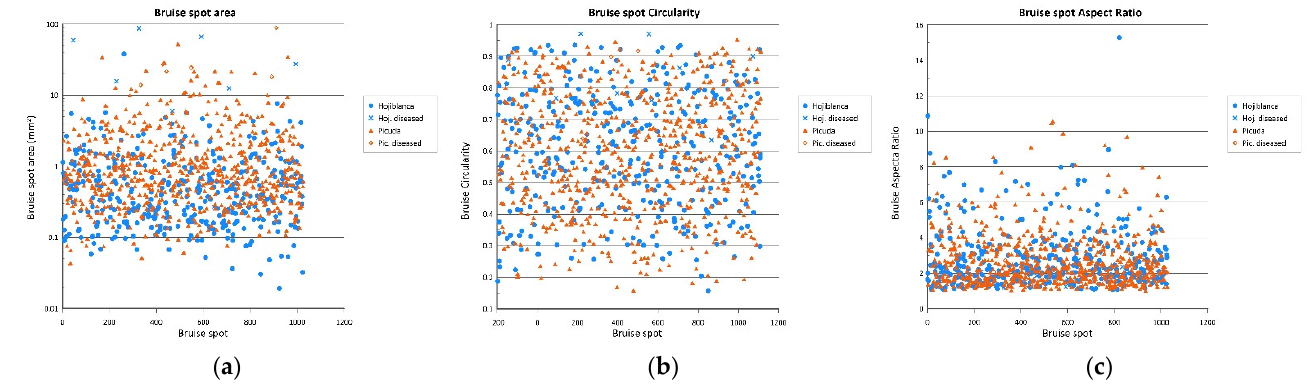
Figure 18. ( a ) Area of spot bruised distribution, ( b ) Bruise spot circularity distribution, ( c ) Bruise spot Aspect Ratio.